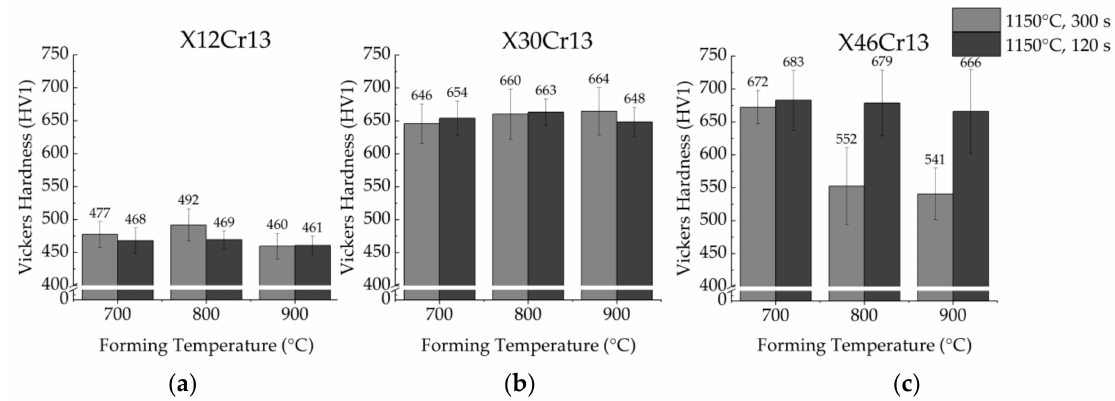
Figure 11. Mean hardness HV1 and standard deviation of the cup cross section for thermomechanical treatment after initial austenitization at 1150 ◦ C for 120 s or 300 s and forming at 700 ◦ C, 800 ◦ C and 900 ◦ C for the X12Cr13 ( a ), X30Cr13 ( b ) and X46Cr13 ( c ) alloys.